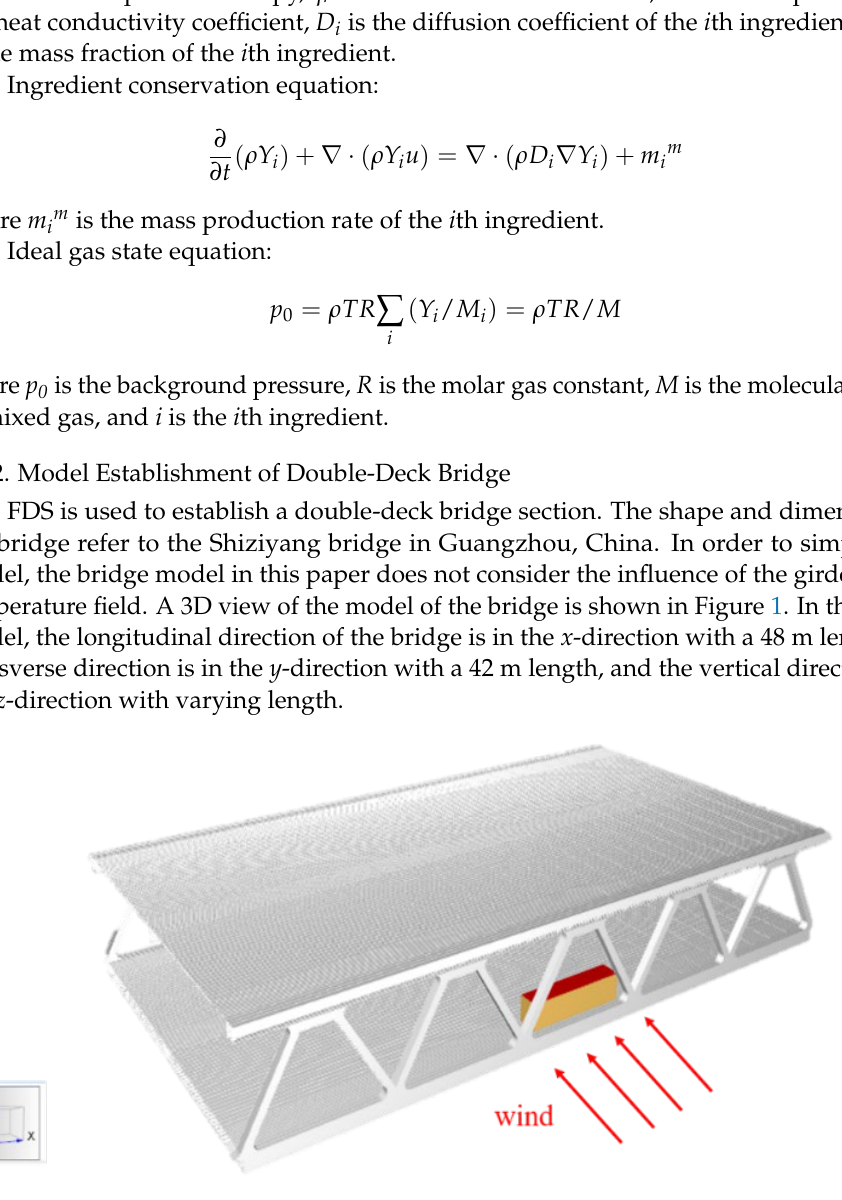
Table 1. Parameters of materials used in the bridge model.